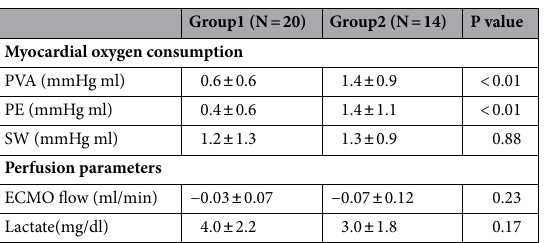
Table 3. Between groups pre-post comparison of cardiovascular parameters. PE potential energy, PVA pressure–volume area, SW stroke